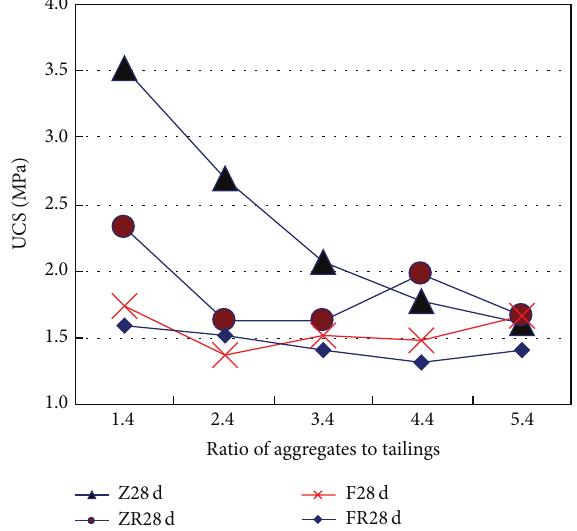
Figure 8: Backfill slurry slump using 12% cement